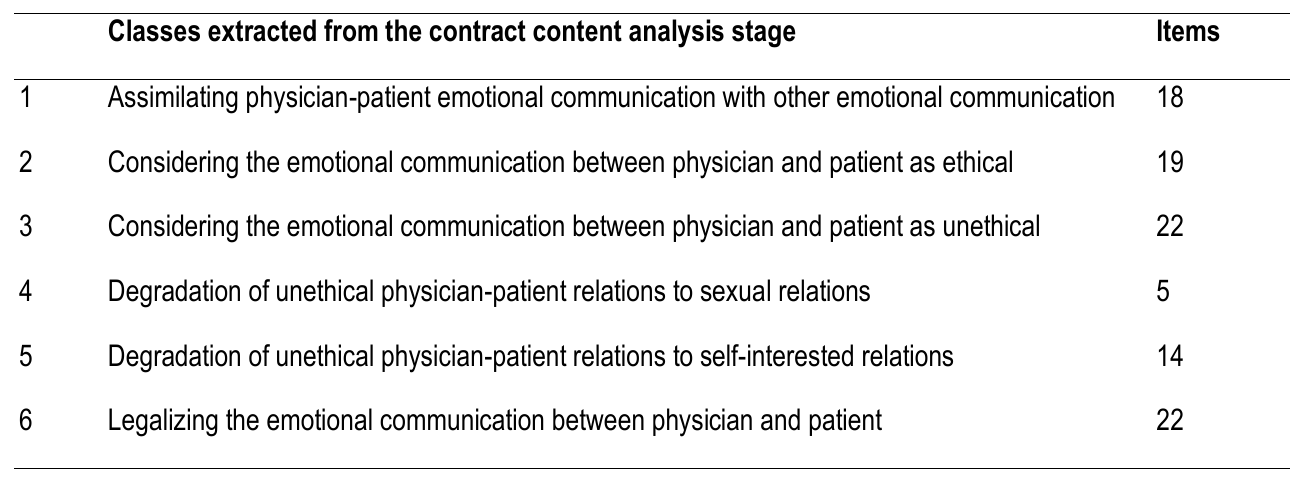
Table 1. Classes extracted from the qualitative stage of the study